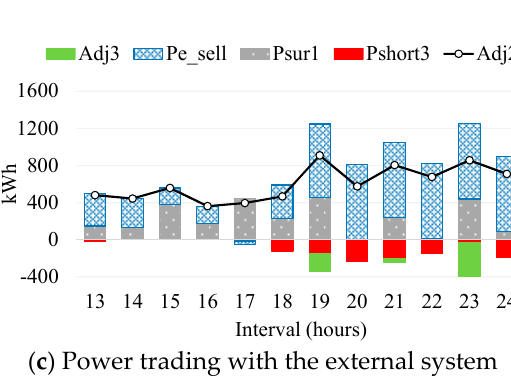
Figure 11. Rescheduling for the event case at interval 13 during a weekday.